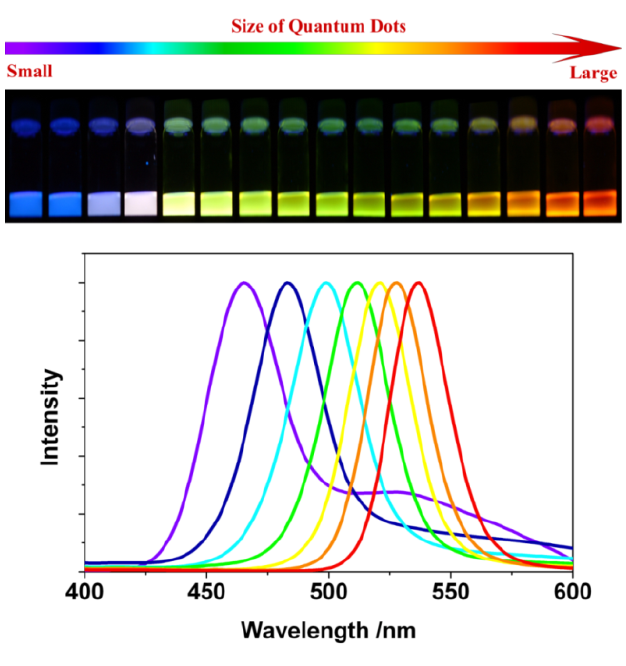
Figure 1. Top: Sixteen emission colors from small (blue) to large (red) CdSe Qdots excited by a near-ultraviolet lamp; size of Qdots can be from ~1 nm to ~10 nm (depends on several parameters, see text for details). Bottom: Photoluminescence spectra of some of the CdSe Qdots